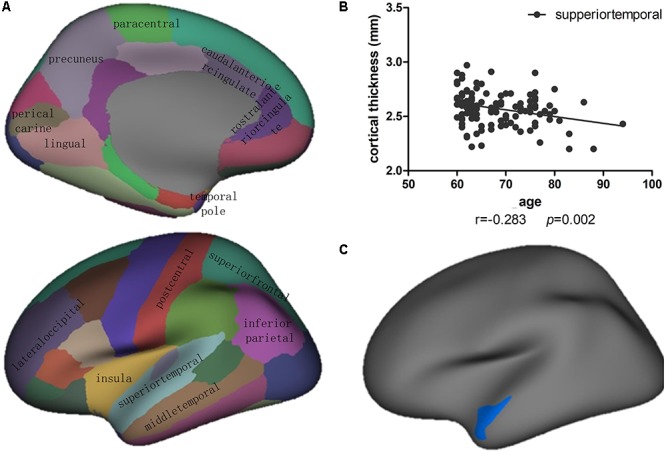
(A) Correlation and linear regression analysis showed that the cortical thickness of multiple cortical regions were significantly correlated with age in 114 cognitively normal aging subjects with non-alcohol consumption (p < 0.05). (B) The correlation of superiotemporal thickness with age showed as the scattered figure. (C) Vertex-based analysis of cortical thickness revealed that the left superiortemporal cluster showed significant difference between alcohol (n = 25) and non-alcohol (n = 49) consumption group without female subjects. Blue indicates that the cortical thickness of a cluster in the alcohol group was thinner than in the non-alcohol group (p < 0.05).